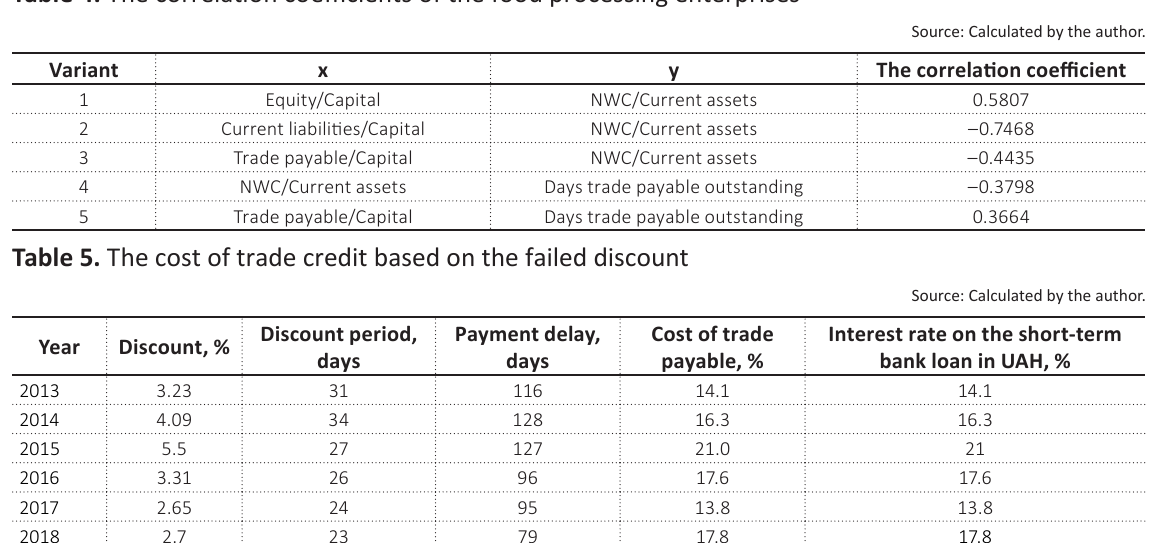
Table 4. The correlation coefficients of the food processing enterprises